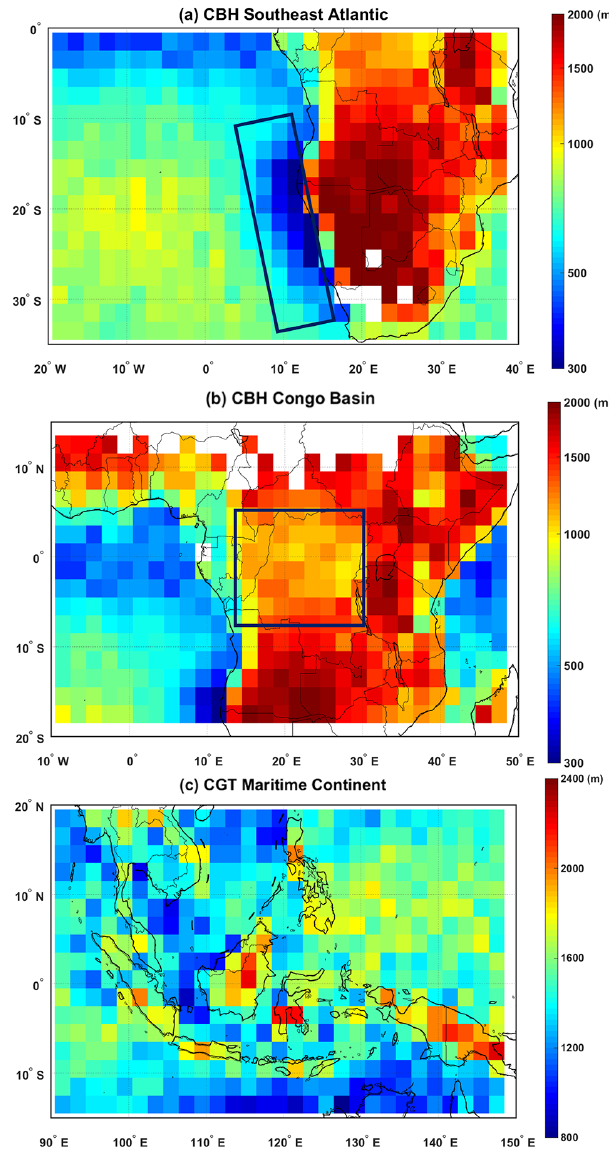
Figure 15. Geographic distributions on a 2 ◦ × 2 ◦ latitude–longitude grid in 2014 and 2017. (a) CBH over the Southeast Atlantic; (b) CBH over the Congo Basin; (c) CGT over the Maritime Con- tinent. The heights are in meters above ground level. The dark blue boxes represent the location of the regions of